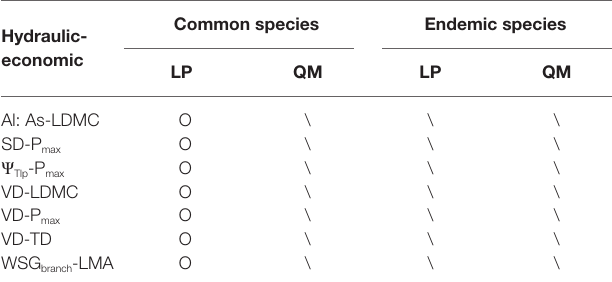
TABLE 2 | According to Figure 5, Supplementary Figures S1 – S5 , list the relationships between hydraulic and economic traits of 20 pairs of congeneric common species and 11 pairs of congeneric endemic species, which changed with soil water availability [O, significant correlation ( p < 0.05); \, no correlation ( p >